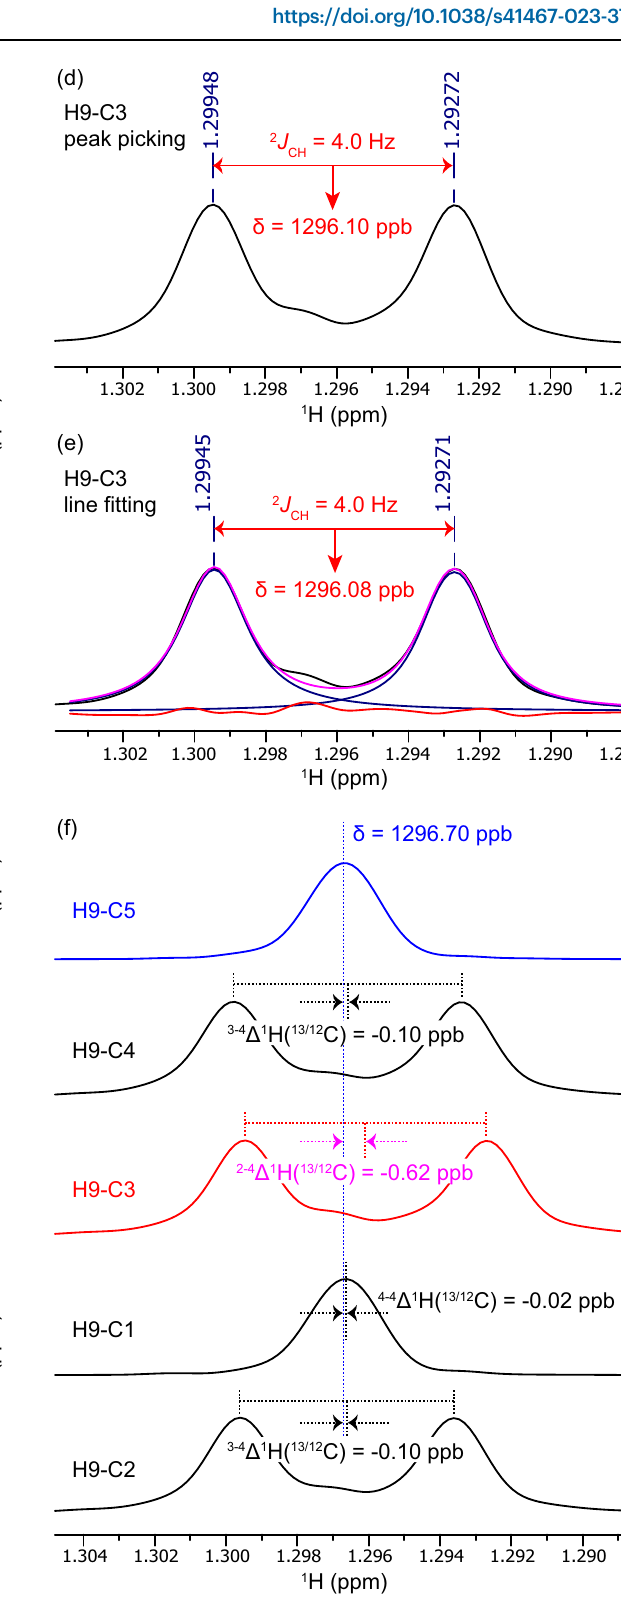
Fig.3|Applicationofi-HMBC/D-i-HMBCmethodologytoidentifythetwo-bond HMBCcorrelationofH9-C3inlinalool( 2 ).a nominal HMBC of H9; b i-HMBC of H9; c D-i-HMBC of H9 ( 2 J CH are in red, the most down fi eld 4 J CH are in blue, the isotope shift difference are in magenta); methods to determine chemical